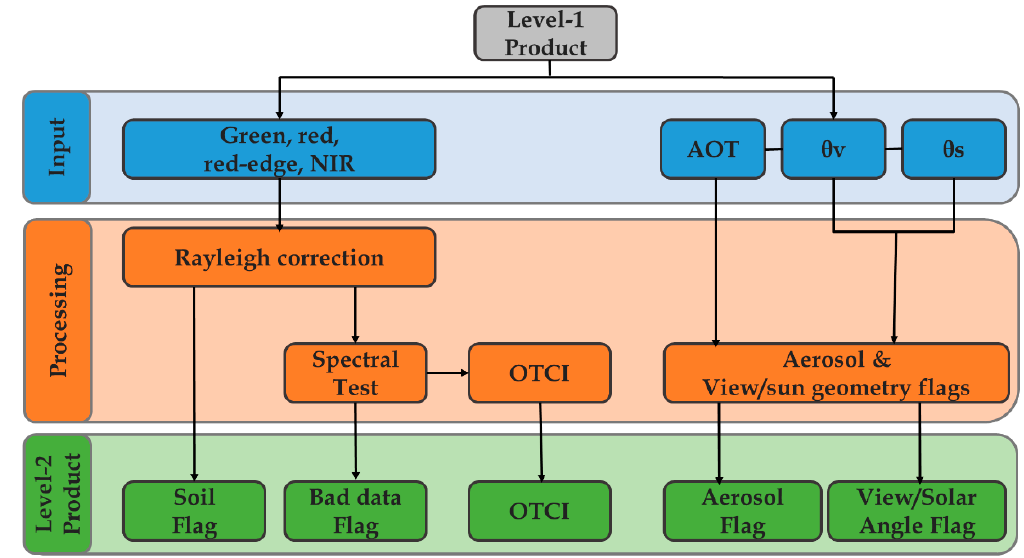
Figure 1. Flow chart of the Sentinel-3 OLCI Terrestrial Chlorophyll Index (OTCI) algorithm. AOT stands for aerosol optical thickness, Θ v and Θ s are the view angle and the solar angle, respectively.